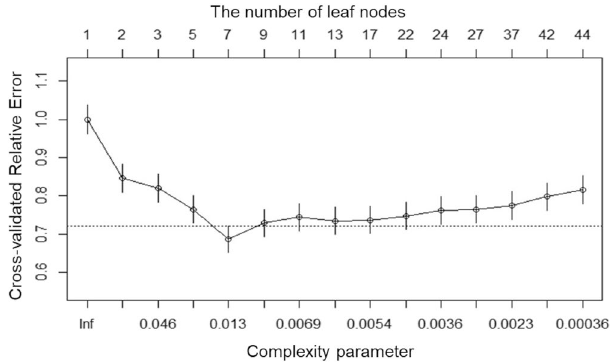
Figure 3. Parameters of the 10-fold cross-validated decision tree model. The primary parameter for selecting the model is the minimum value of the cross-validated relative error (the lowest value is selected in further analyses). R, version 4.0.2, https:// www. rstud io.